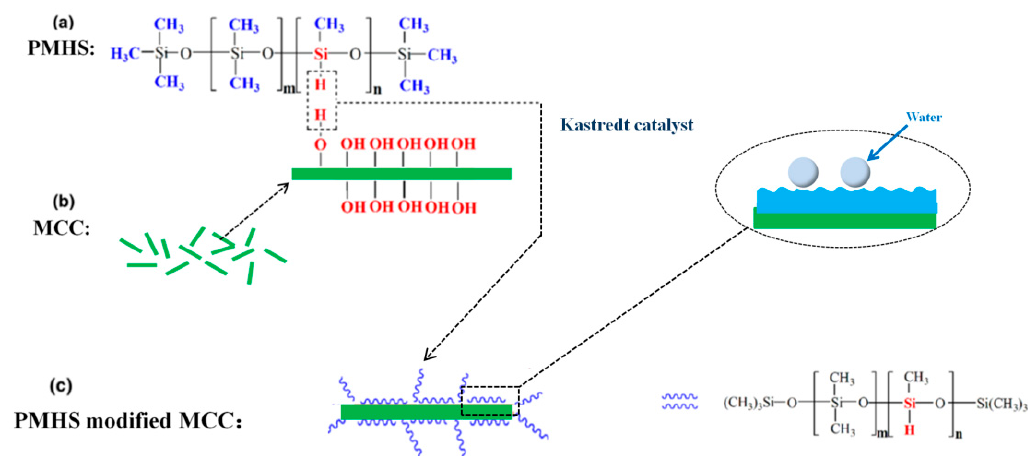
Figure 2. The schematic representation of PMHS ( a ), MCC ( b ), and PMHS modified MCC ( c ).